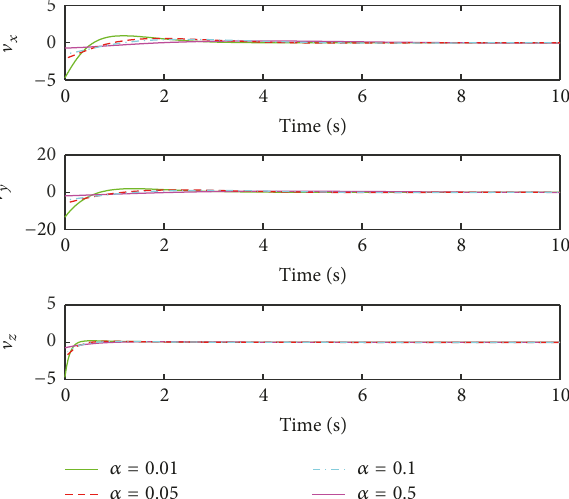
Figure 5: Optimal virtual control signal with different